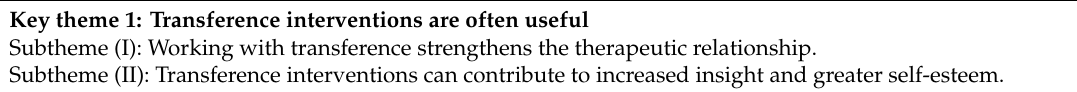
Table 1. How do therapists experience psychodynamic therapies, with and without transference interventions, for adolescents with